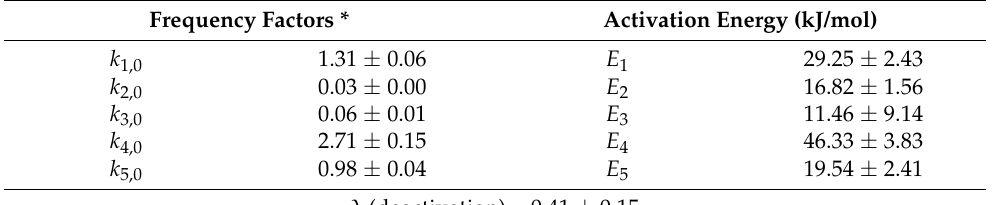
Table 4. Estimated Kinetic